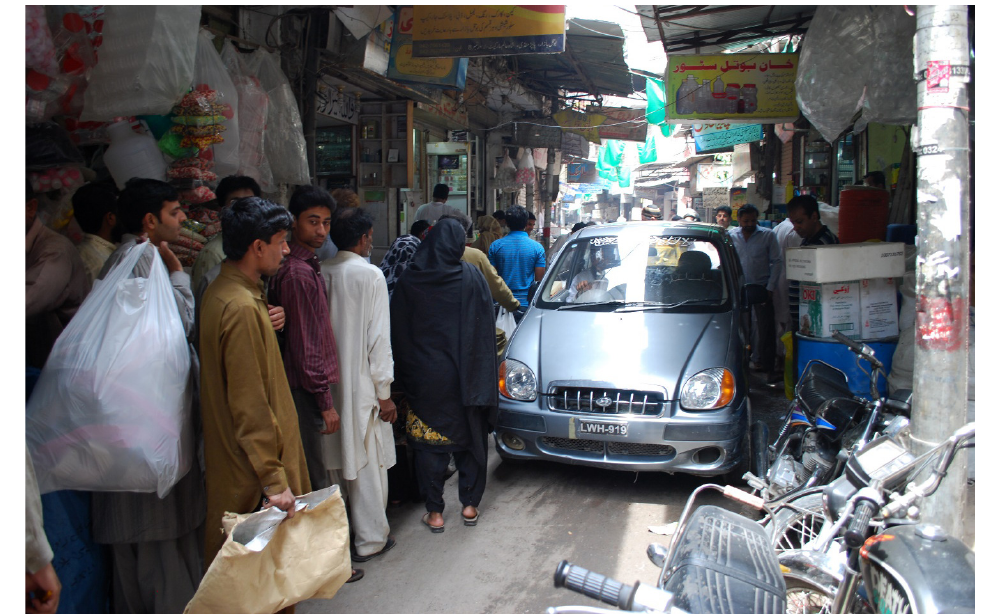
Figure 3. Congested street in the Walled City. Photo by Katja Mielke (2012).